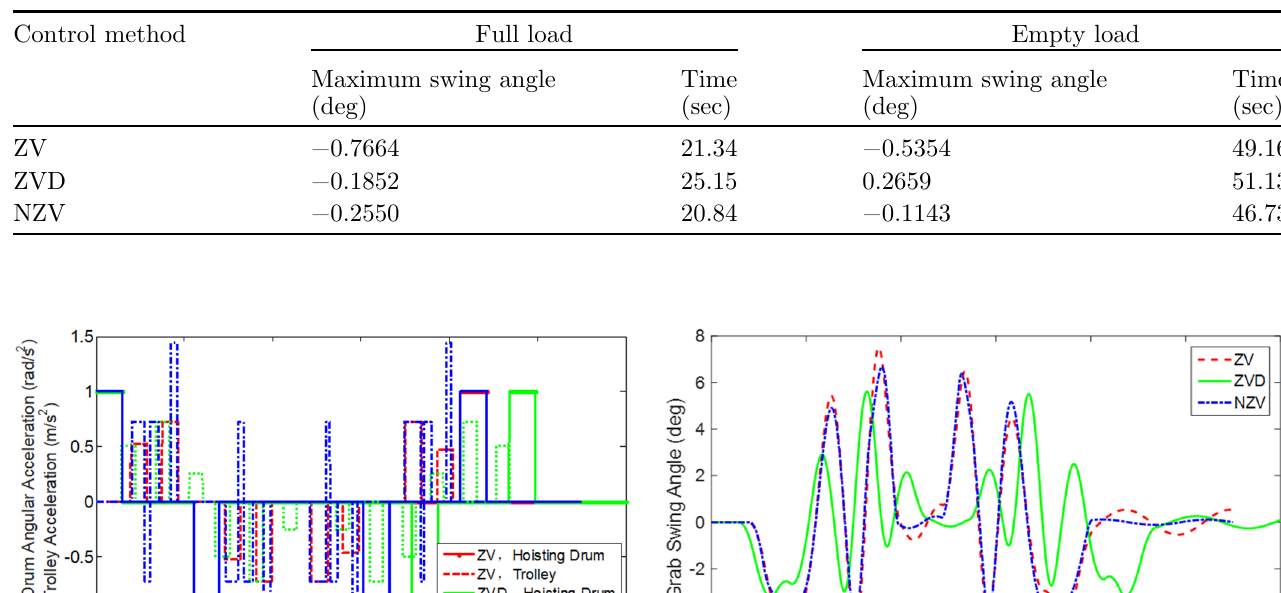
Table 3. Maximum residual swing angles for the conditions of the full load and empty load under different control